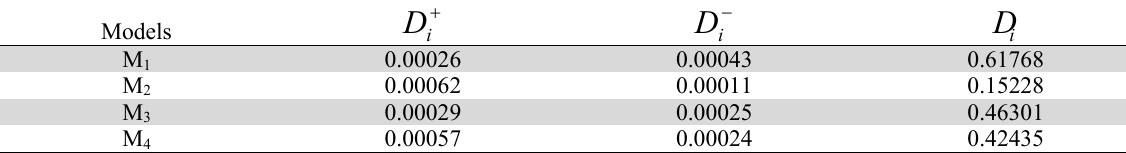
Proportional distance of the mini-grid business models